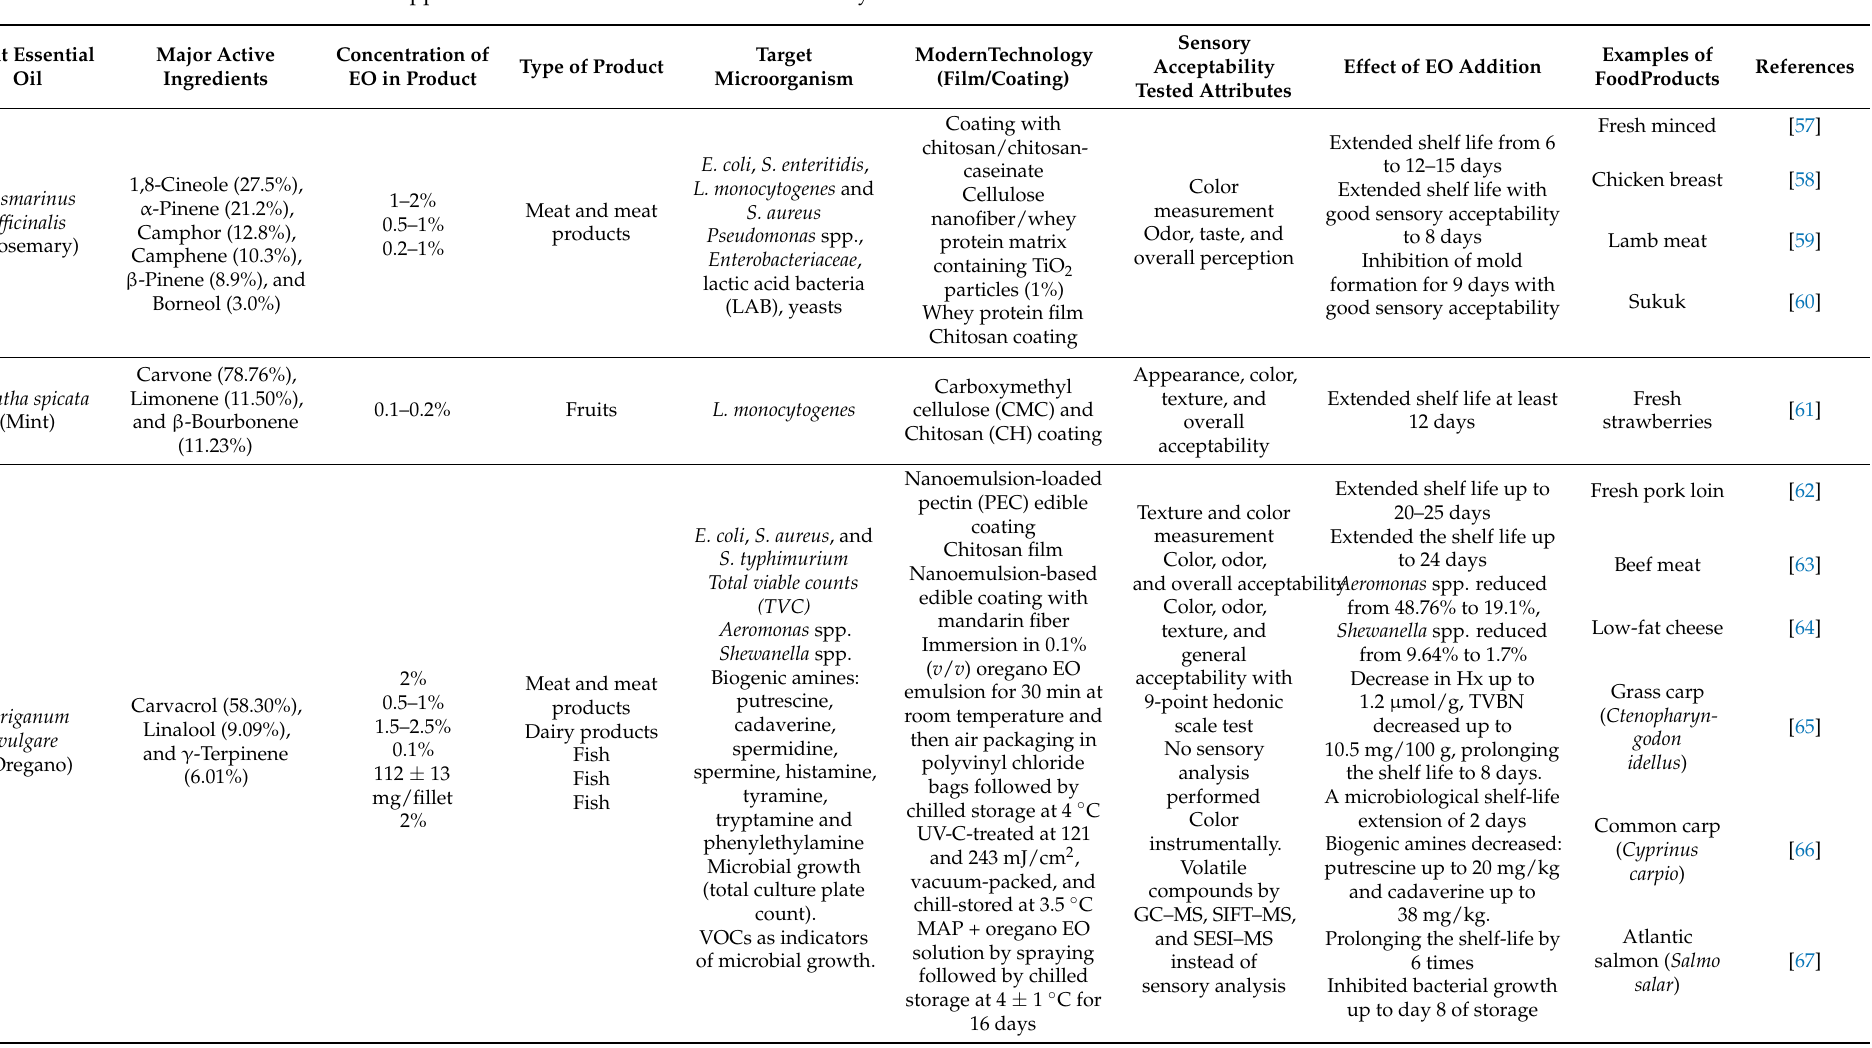
Table 1. The application of essential oils in the food